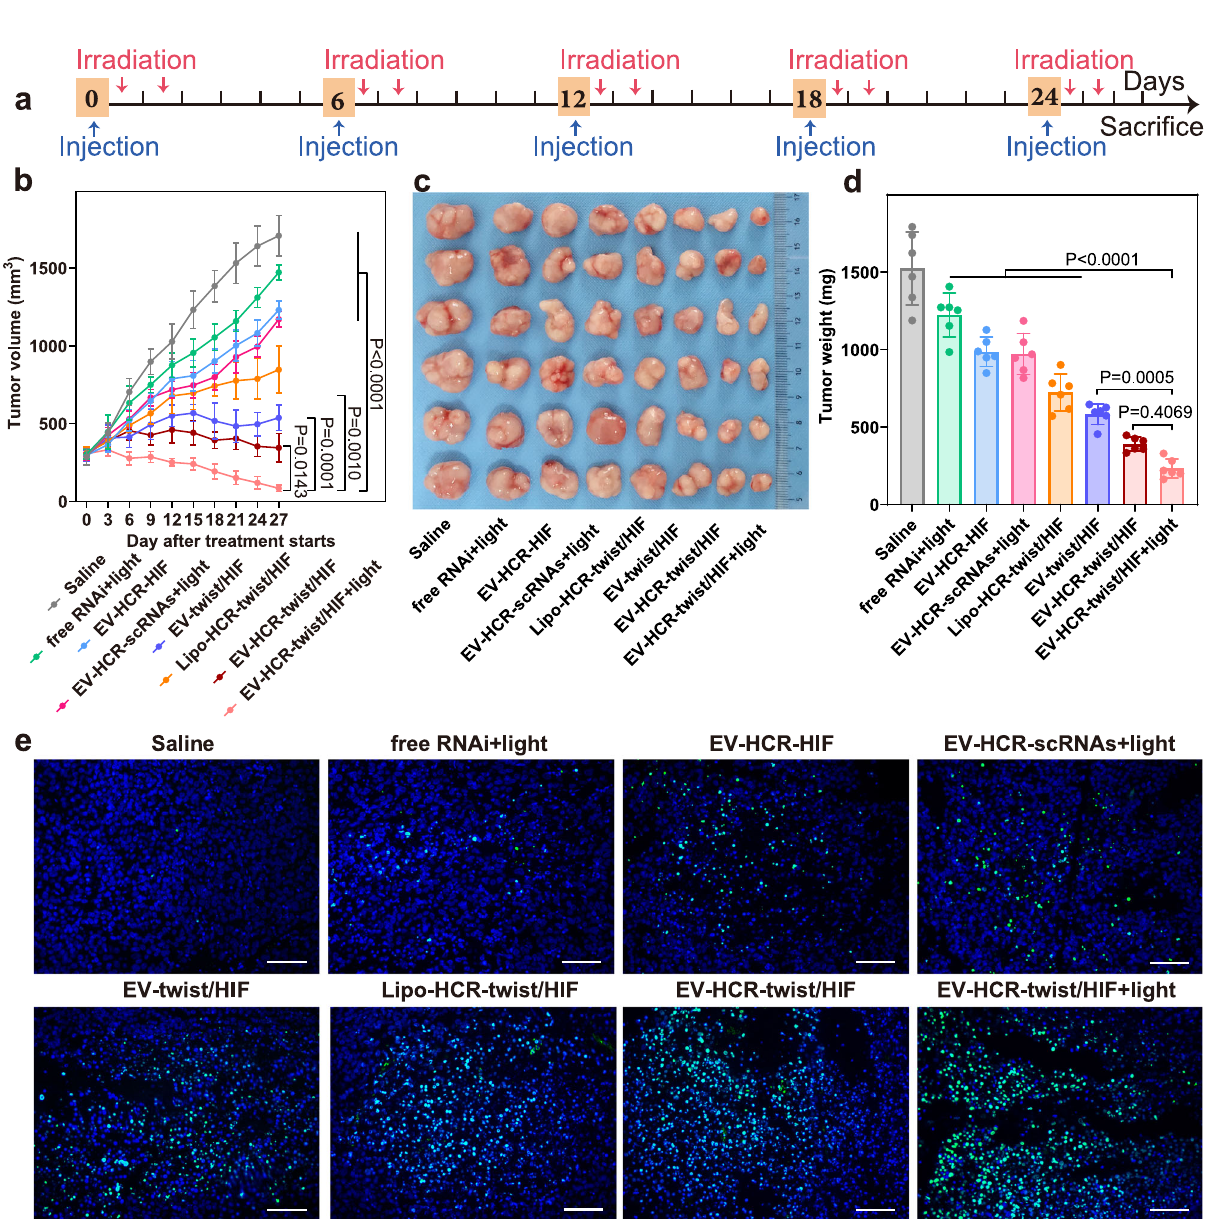
Fig. 5 In vivo combined bis-gene therapy and PTT for MDA-MB-231 tumour eradication. a Schematic of the therapeutic protocol used in tumour-bearing mice. b Time-dependent tumour growth pro fi les of mice that were treated with saline, free RNAi prodrugs with photoirradiation, EV-sustained HCR- stimulated HIF-1 α , EV-sustained HCR-scrambled-siRNAs with photoirradiation, liposome-sustained HCR-stimulated twist/HIF-1 α , EV-sustained direct twist/HIF-1 α , EV-sustained HCR-stimulated twist/HIF-1 α and EV-sustained HCR-stimulated twist/HIF-1 α with photoirradiation. All photoirradiation was carried out with an 808 nm laser (0.7 W/cm 2 ) for 5 min. c Representative tumour images and d the average tumour weights of mice subjected to the different treatments. e TUNEL analysis of the tumours of mice subjected to different treatments. All scale bars are 200 μ m. Data represent the mean ± s.d. from six ( b , d ) independent replicates. The images are representative of three independent animals. Statistical signi fi cance ( b , d ) is calculated by two-way ANOVA followed by Bonferroni ’ s multiple comparisons test. Source data are provided as a Source Data fi